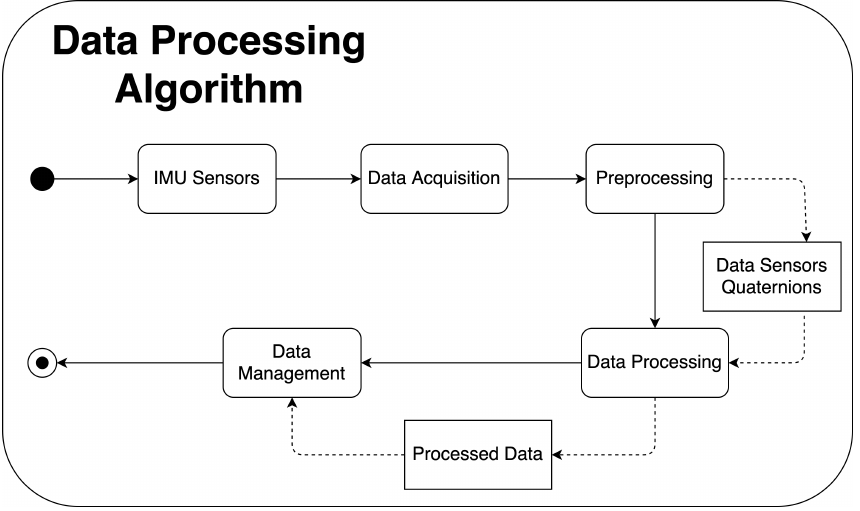
Figure 3. Block diagram of the data processing